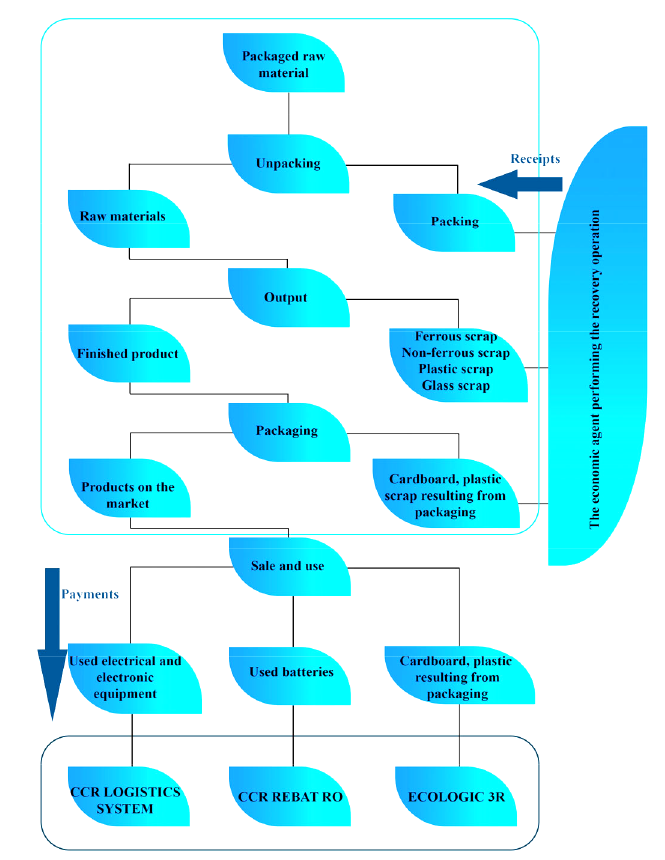
Figure 1. The interaction between the production activity and the